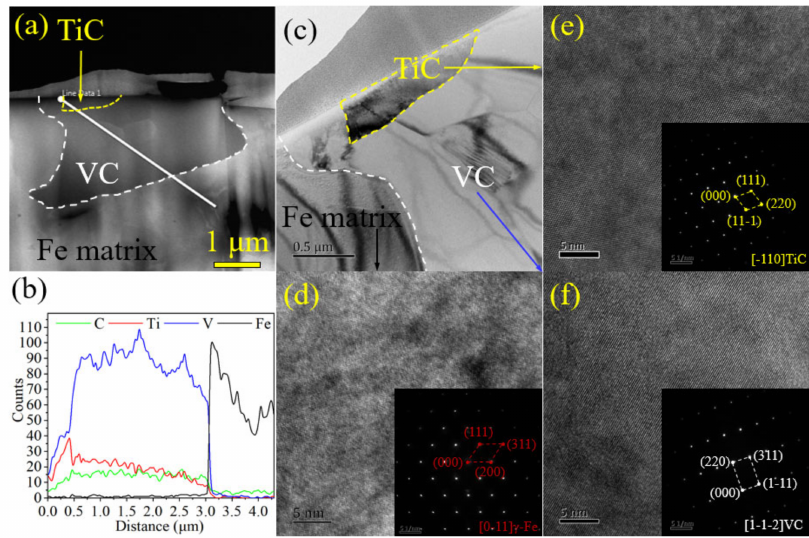
Figure 6. The HR-TEM image and electron-diffraction spot of the rich Ti region throughout the VC in the representative 4.5 Mn sample: ( a ) SEM image and composition distribution in the line-scan results; ( b ) magnified image in the ( a ); and ( c – f ) HR-TEM image and their corresponding electron-diffraction spots of TiC, Fe, and VC.